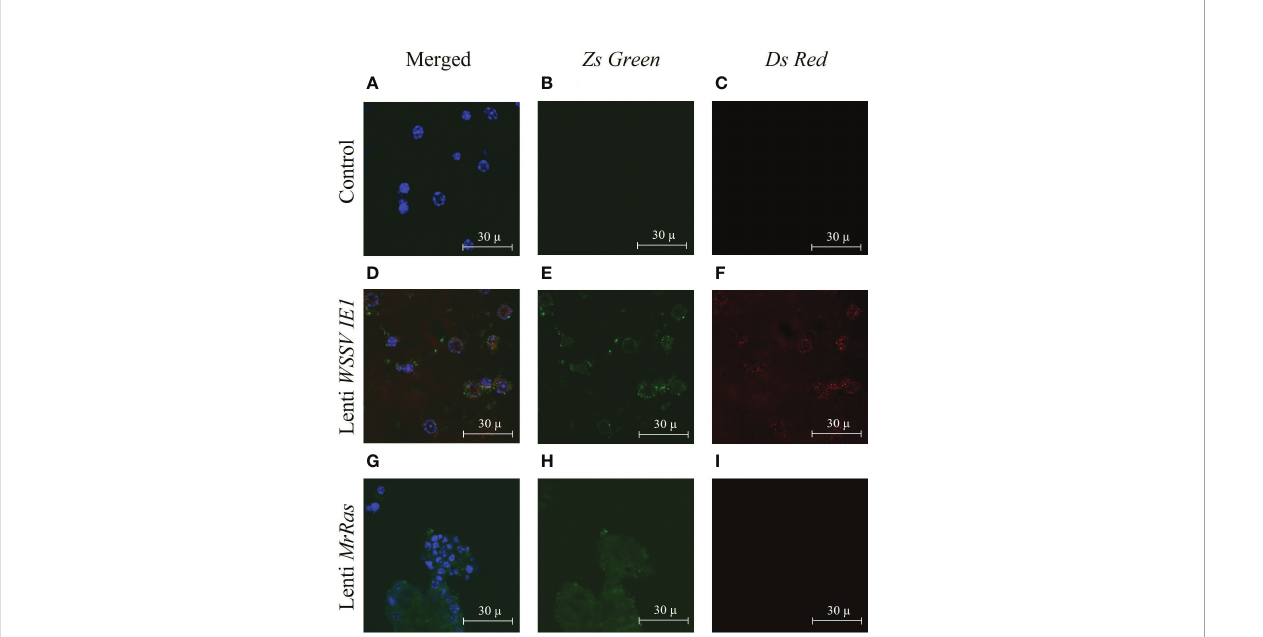
FIGURE 5 Expression of lentiviral particles in M. rosenbergii embryonic primary cell culture three days after transduction, as seen by confocal microscopy: (A-C) Representative images of control non-transduced cells, (D-F) Lenti WSSV IE1 transduced cells, and (G-I) mutated lenti MrRas transduced cells. Cultures were examined by confocal microscopy (using the appropriate lasers, 488 nm for ZsGreen and 546 nm for DsRed). The ‘ Merged ’ panel (A, D, G) on the left of the Figure shows additional nucleic acid staining performed with DAPI (and visualized with a 405 nm laser). Scale bar = 30